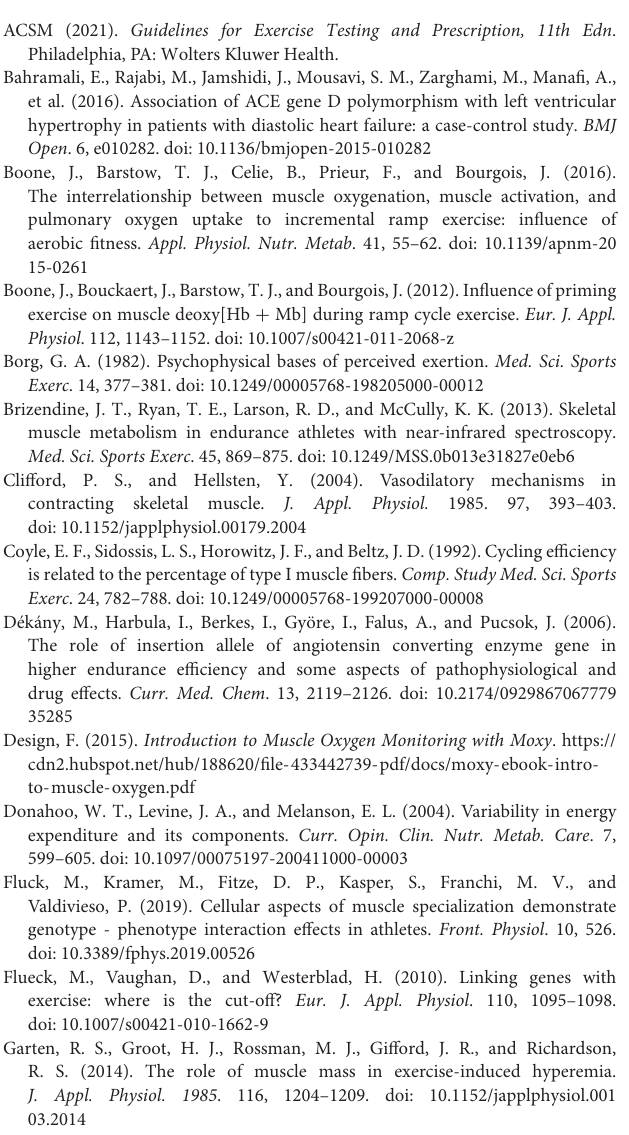
Supplementary Table 2 | Prospective power analysis. Calculation of the prospectively required number of biological replica to reveal statistically significant associations. Supplementary Table 3 | Association of fitness state × genotype for control coefficients characterizing the pathway of oxygen. List of the significance ( p ) and effect size (h2) of the interaction effects between aerobic fitness × ACE-I/D genotype on the control coefficients for the parameters of the pathway of oxygen and power output during the metabolic phases of the exercise test. ANOVA. Bold underlined values met the criteria of p < 0.05. N =